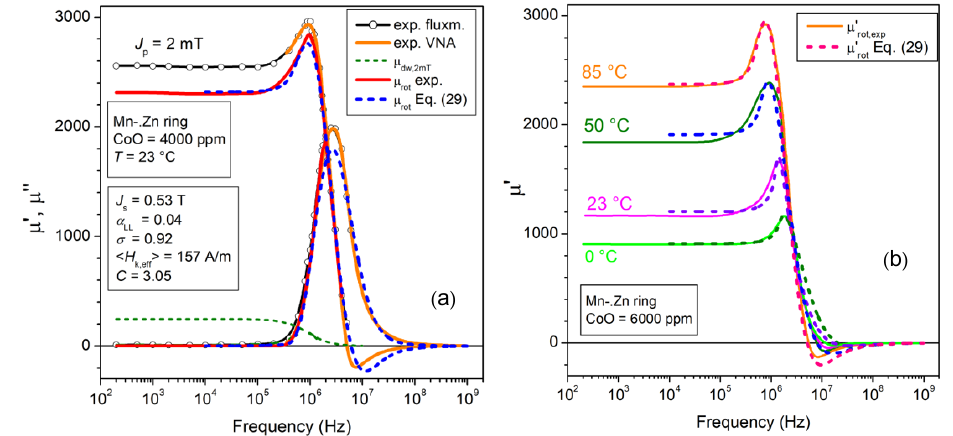
Figure 11. ( a ) Example of permeability decomposition in a 4000 ppm CoO-doped Mn-Zn ring sample. μ ′ rot ( f ) and μ ″ rot ( f ) are singled out according to Equations (20) and (23) (continuous lines) and compared with their theoretical prediction μ ′ rot,sd ( f ) and μ ″ rot,sd ( f ) (dashed lines), as derived from the Landau–Lifshitz equation and the assumed lognormal distribution for the effective anisotropy field H k,eff (Equation (29)). ( b ) Experimental µ (cid:48) rot ( f ) at different temperatures in a 6000 ppm CoO- doped sample and its prediction as µ (cid:48) rot,sd ( f